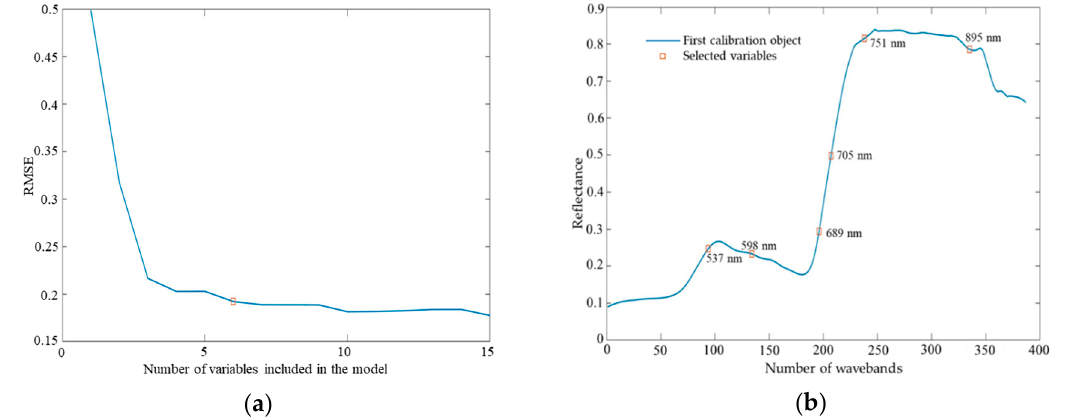
Figure 5. (a) Change of the root mean square error (RMSE )in the successive projections algorithm (SPA); (b) the optimal wavebands (OWs) selected using SPA.